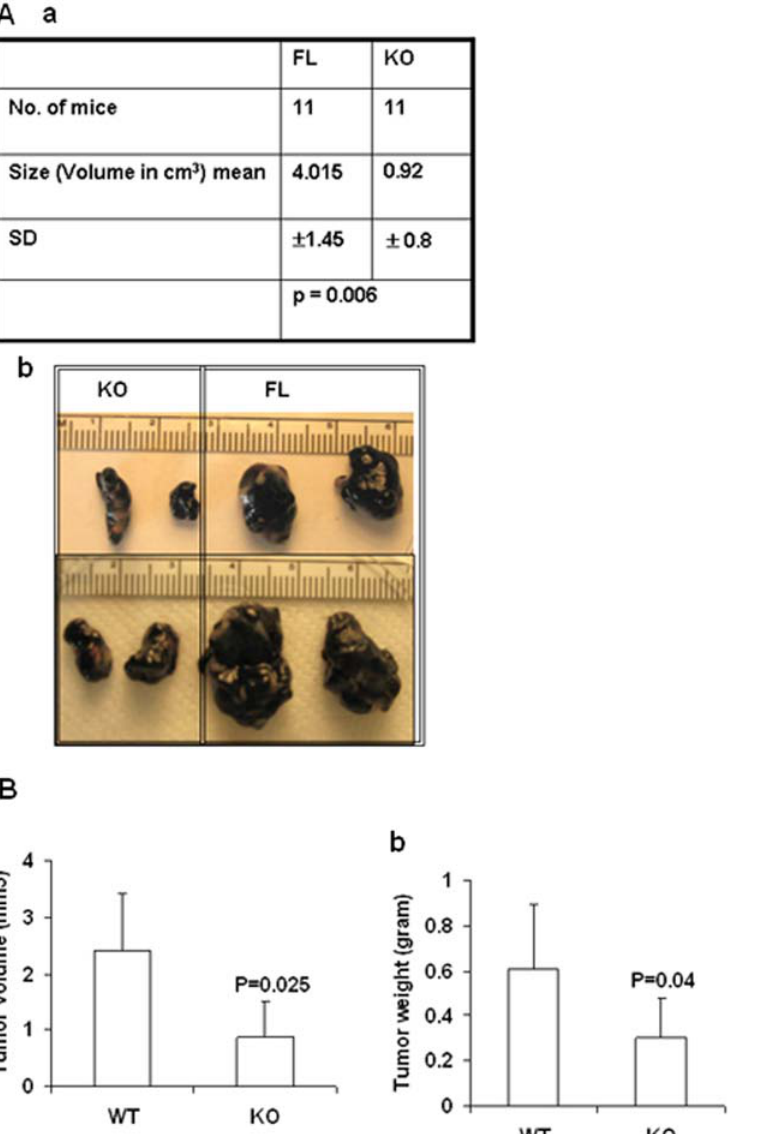
Figure 10. Melanoma growth was suppressed in OGR1 KO mice in both mixed and C57/BL6 backgrounds. (A, a ) Tumorigenesis of melanoma cells was reduced in OGR1 KO mice in the mixed background. B16-F10 cells (10 7 mouse melanoma cells) were injected s.c into FL and KO mice in the mixed background. Mice were sacrificed at 9–14 days post-injection. ( b ) Representative pictures of the tumors developed in FL and KO mice in the mixed background. (B ) . Summary of tumor volumes (a) and weights (b) in mice with the C57/BL6 background (n=10 in WT and n=12 in KO). Tumorigenesis of melanoma cells was reduced in OGR1 KO mice.